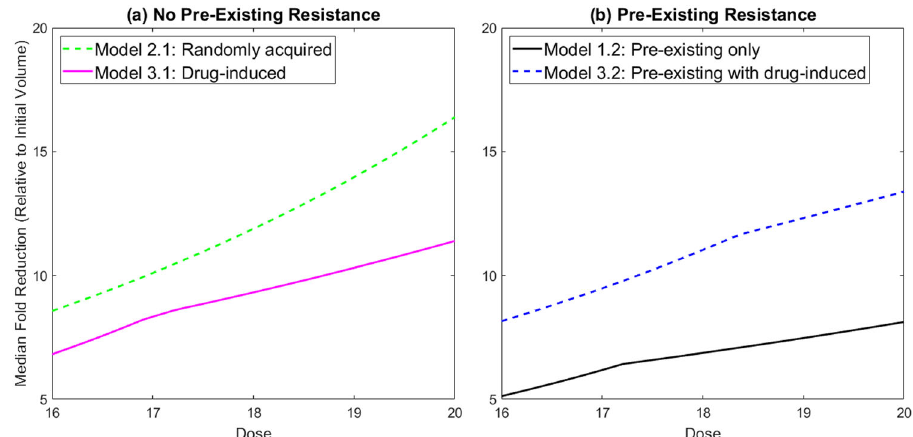
Fig. 7 Dose escalation study of median reduction in tumor volume (relative to initial volume) after 2 weeks. Dose varies from 16 to 20 mg/ kg. Growth is assumed to be exponential. a Plausible models involving no pre-existing resistance. b Plausible models including pre-existing